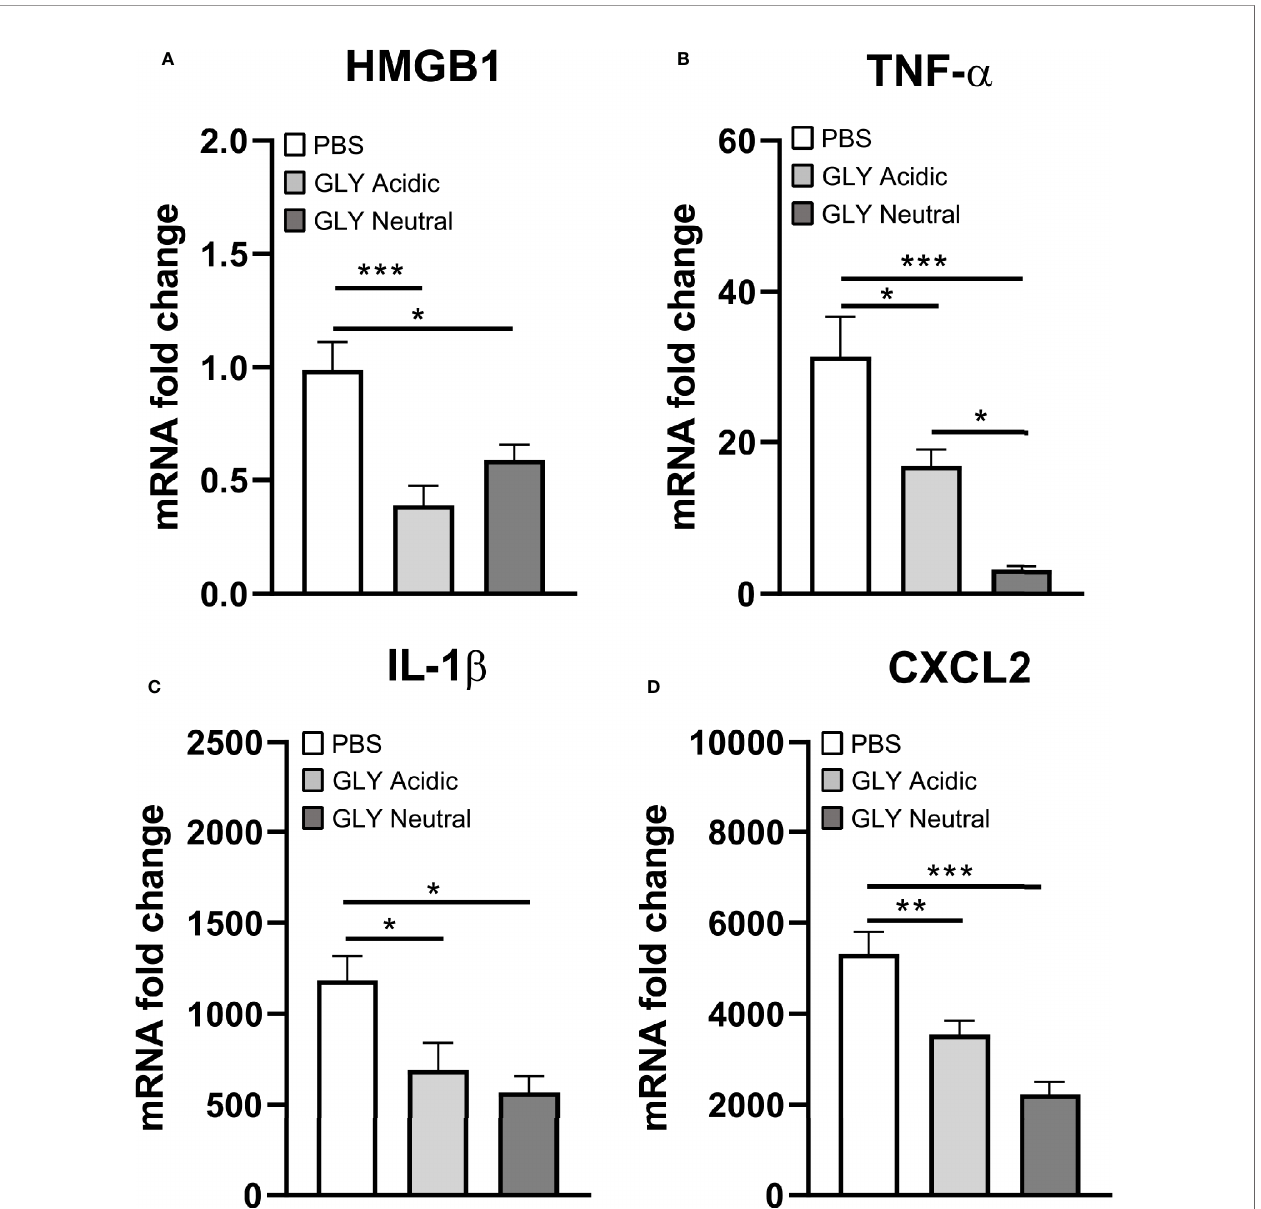
FIGURE 5 | Effects of GLY pH on mRNA levels of cytokines in corneas infected with KEI 1025 and treated with PBS or acidic or neutral GLY. Signi fi cantly reduced mRNA expression for HMGB1 (A) , TNF- a (B) , IL-1 b (C) , and CXCL2 (D) after acidic or neutral GLY vs . PBS treatment was observed at 5 days p.i. Data are expressed as mean ± SEM (*p < 0.05, **p < 0.01, ***p < 0.001, n =